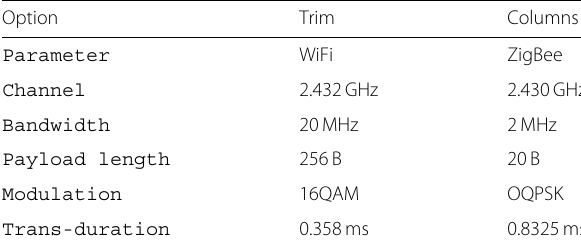
Table 1 Experiment configuration